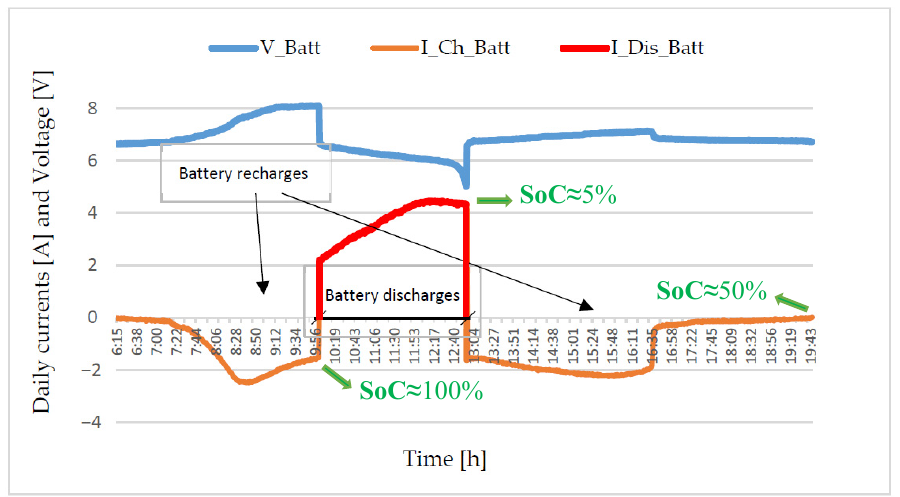
Figure 17. Daily curves of (i) the charging current of the battery (I_Ch_Batt), (ii) the discharging current of the battery (I_Dis_Batt), and (iii) the voltage of the battery (V_Batt) during the experiment referred to in Figure 16. The values of the state of charge (SoC) of the battery are also reported, as estimated offline in correspondence to most relevant time occurrences.